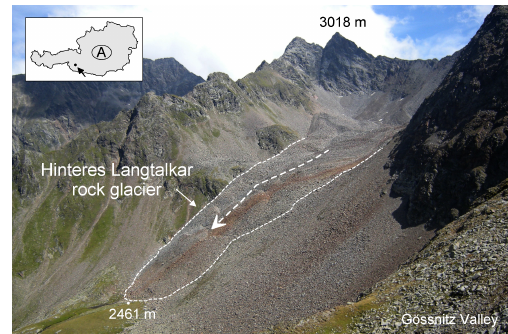
Figure 1. Terrestrial view of Hinteres Langtalkar rock glacier. The rock glacier tongue is moving over a break-in-slope into steeper terrain causing sliding of its frontal slope. Photograph taken by V. Kaufmann on 22 August